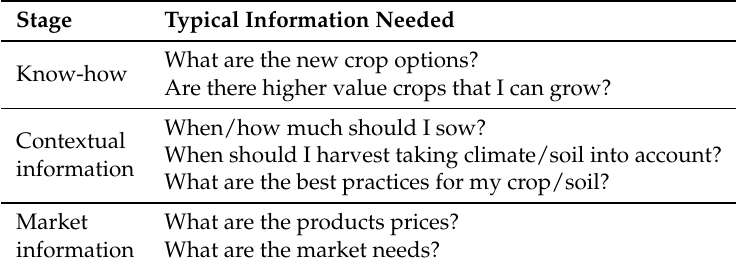
Table 1. Information that the farmer needs at each stage